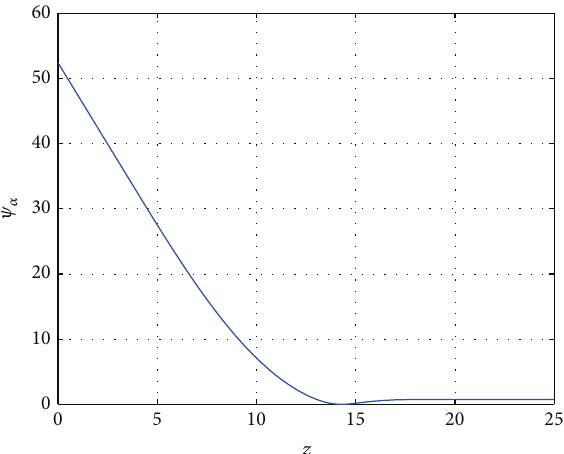
Figure 2: The pairwise attractive/repulsive potential